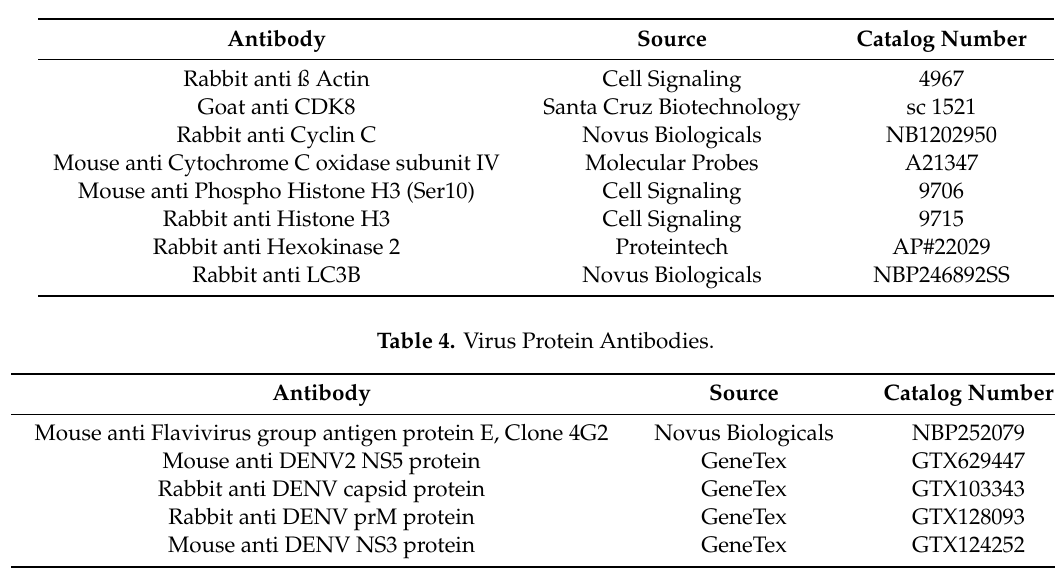
Table 3. Cell Protein Antibodies.